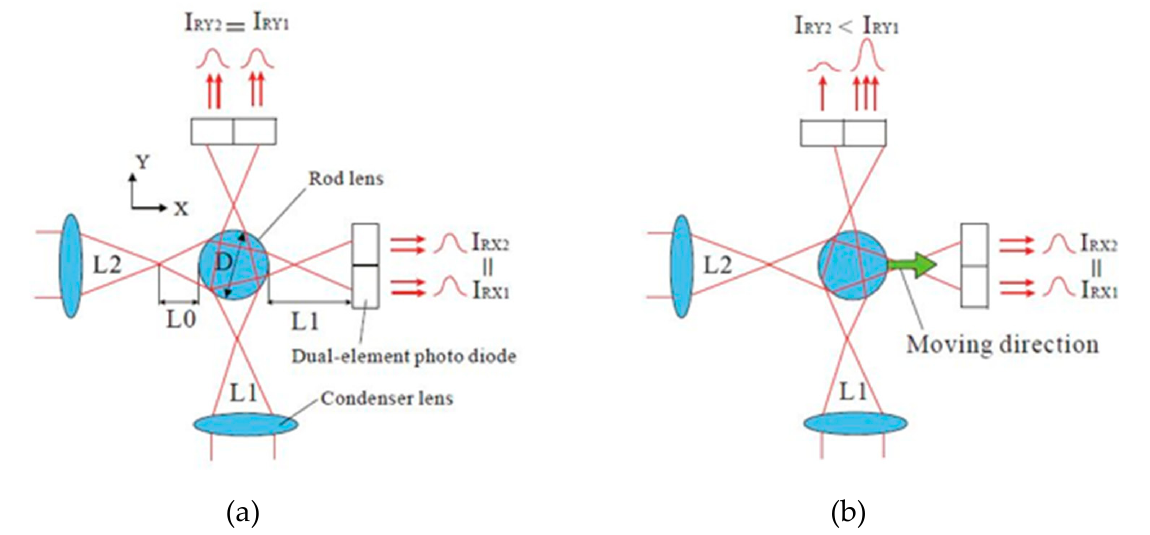
Figure 25. Principle of measurement: ( a ) initial state and ( b ) shift in the X axis [28]. The light signals incident on the Ir photodiode halves are converted into voltage. The voltage difference remains in the halves; in the data acquisition and analysis system, it is converted into an offset value. The article also presents the principle of selection of the optical system for the given limit value of the displacement measurement (e.g., − 5 + 5 µ m). The results of the spindle tests (Figure 26) confirmed the usefulness of the system. The resolution of the measuring system is 5 nm.